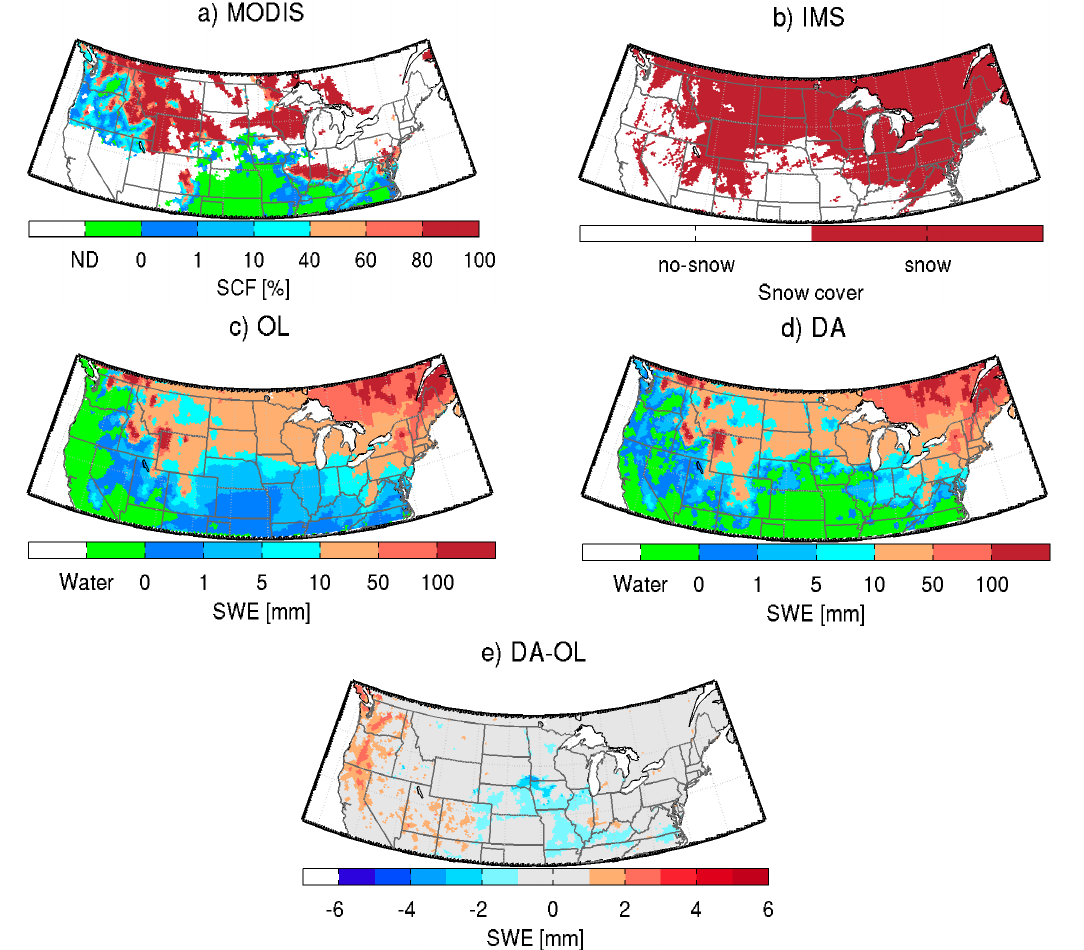
Figure 4. Maps of ( a ) MODIS snow cover (%); ( b ) IMS snow cover; ( c ) open-loop (OL) (model control run) SWE (mm); ( d ) model analysis (DA) SWE (mm) and; ( e ) the difference between DA and OL SWE (mm) for 17 January 2003.